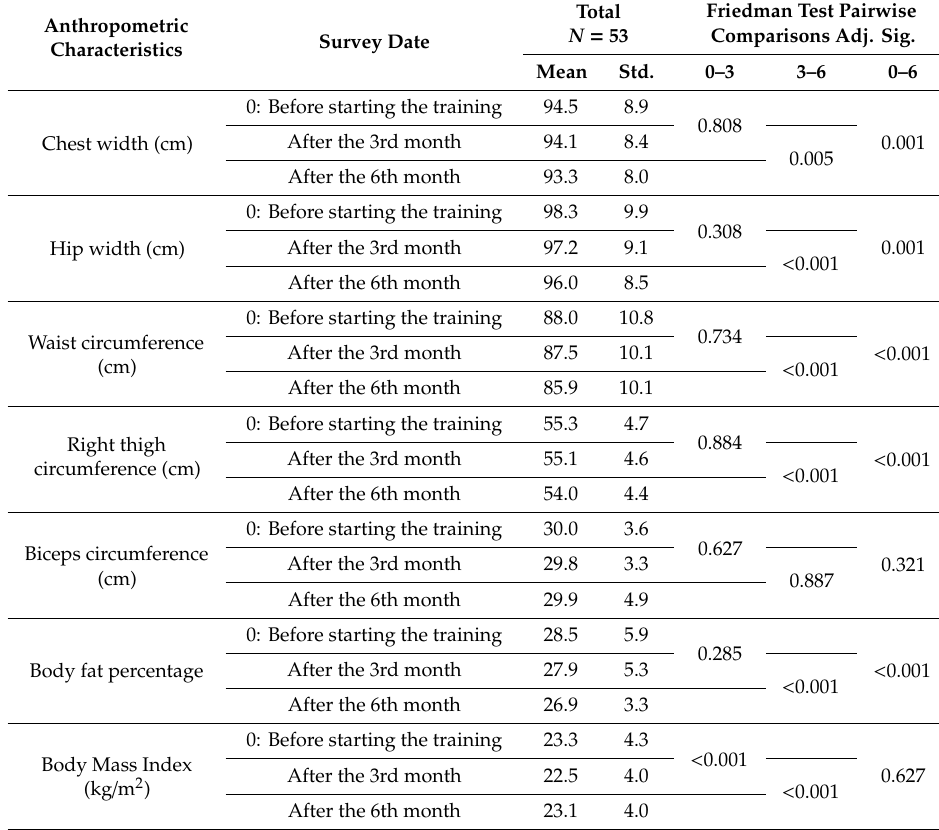
Table 1. Body size means and standard deviation before starting the training, after three and after six months, as well as the significance levels of the Friedman